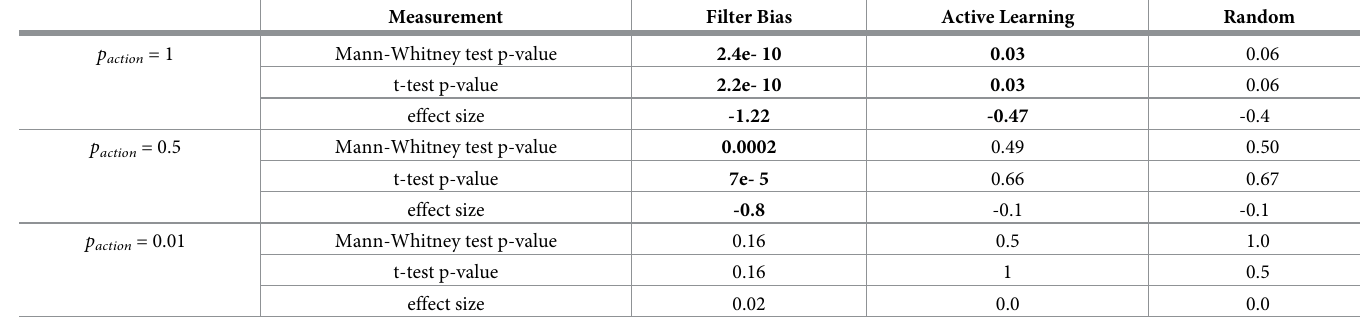
Table 6. Results of the Mann-Whitney U test and t-test for the class-1-blind spot of the computed three forms of iterated algorithmic bias based on the different probability levels of human action. Here, effect size is ES = ( BlindSpot | t = 0 − BlindSpot | t = 200 )/ standard . dev . Bold means the significance at p < 0.05. The more the human reacts to the system, the bigger is the class-1-blind spot size.